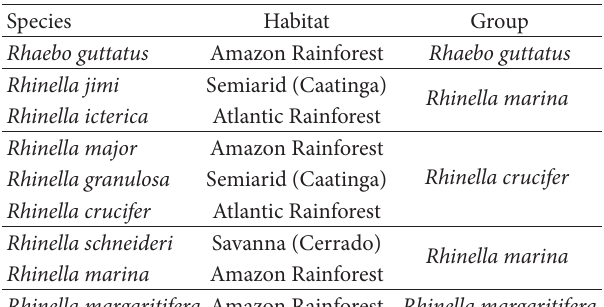
Table 1: Species used in this